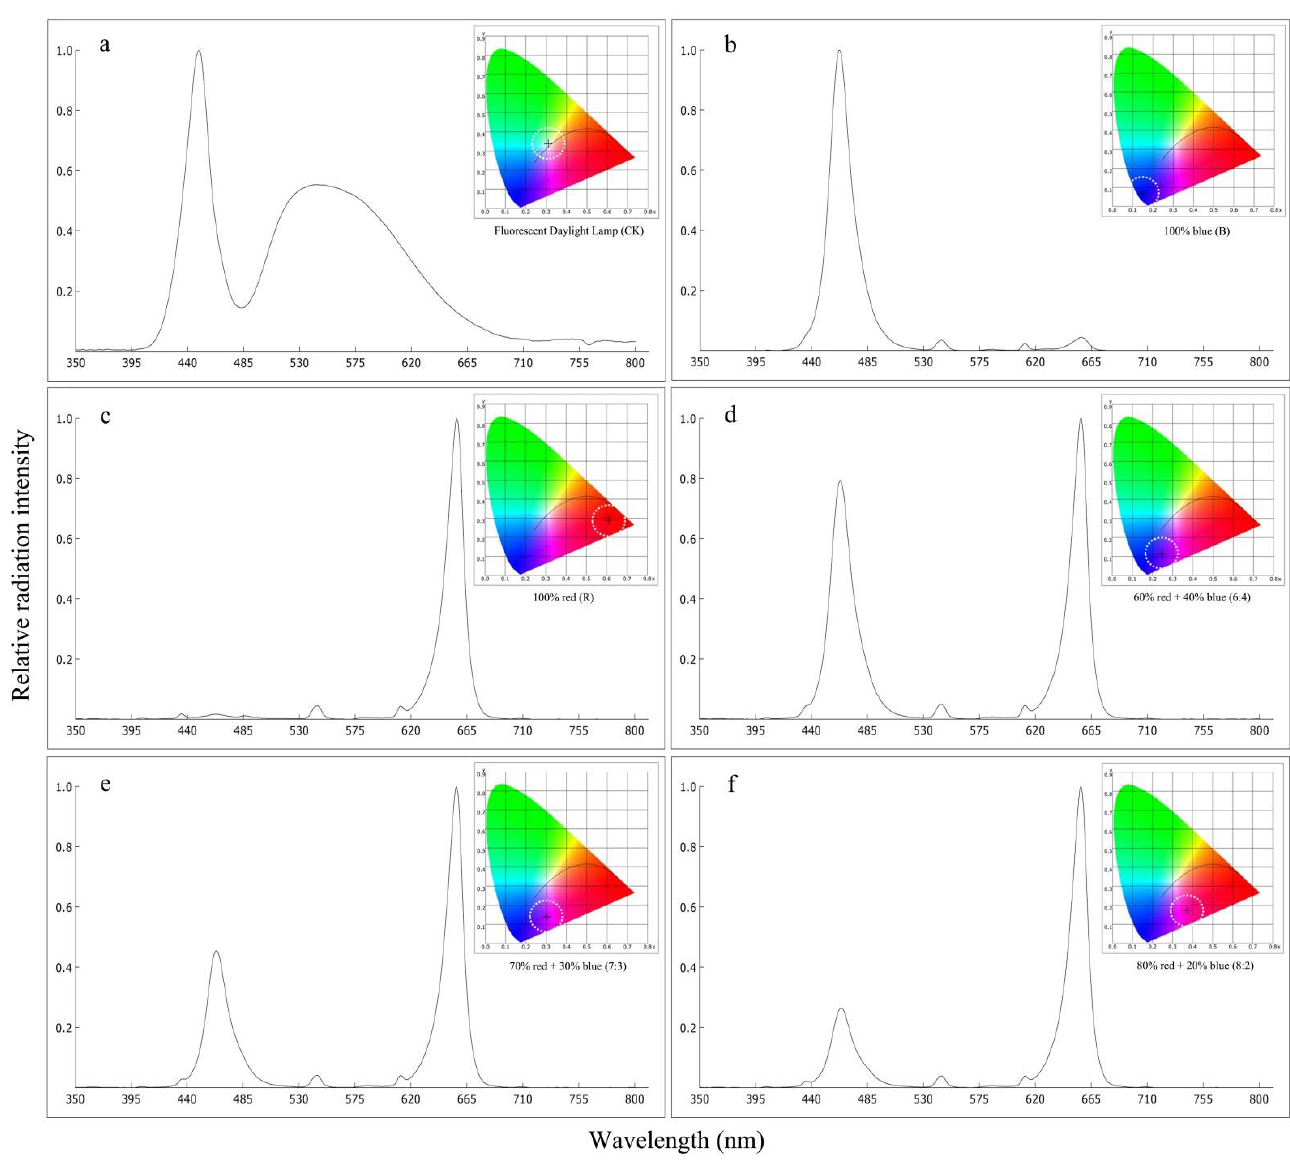
Figure 1. Relative spectral distribution of the fluorescent daylight lamp and LEDs. ( a ) Fluorescent Daylight Lamp as control (CK), ( b ) 100% blue (B), ( c ) 100% red (R), ( d ) 60% red + 40% blue (6:4), ( e ) 70% red + 30% blue (7:3), ( f ) 80% red + 20% blue (8:2). The white circle shows the center of the spectral component marker.